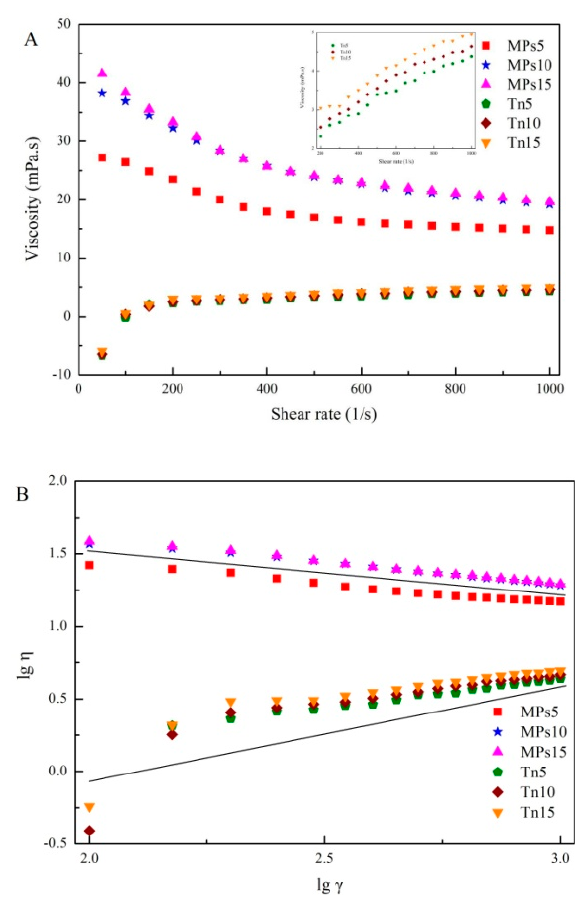
Figure 4. ( A ) Viscosity of MP- or Tween 80-stabilized camellia seed oil emulsions at different homogenization speeds. ( B ) Dependence of lg η versus lg γ . MPs5, MPs10, and MPs15 = gels with MP-stabilized emulsions homogenized at 5000, 10,000, and 15,000 rpm, respectively; Tn5, Tn10, and Tn15 = gels with Tween 80-stabilized emulsions homogenized at 5000, 10,000, and 15,000 rpm, respectively.